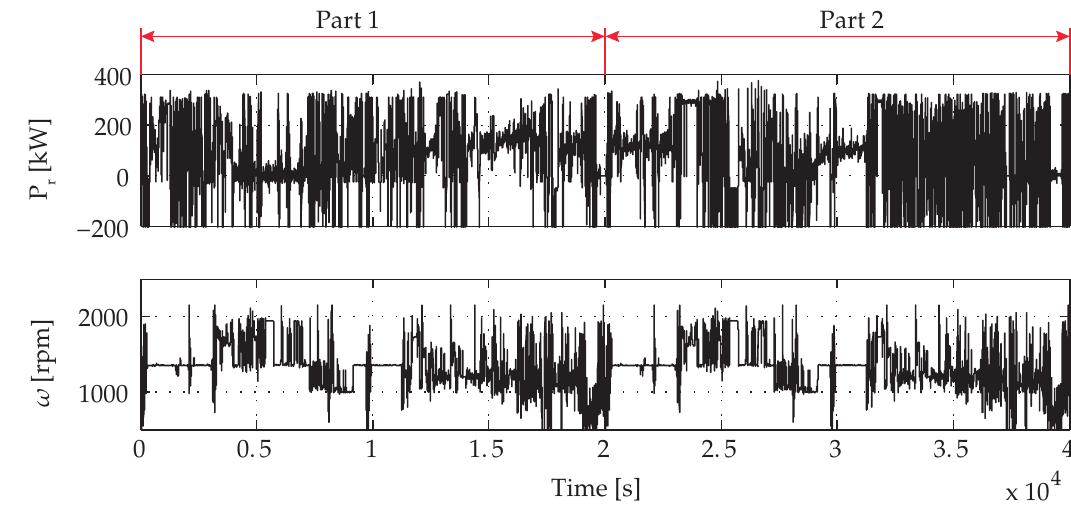
[ 0, 20,000 ] ) and Part 2 ( t Figure 4. Part 1 ( t ∈